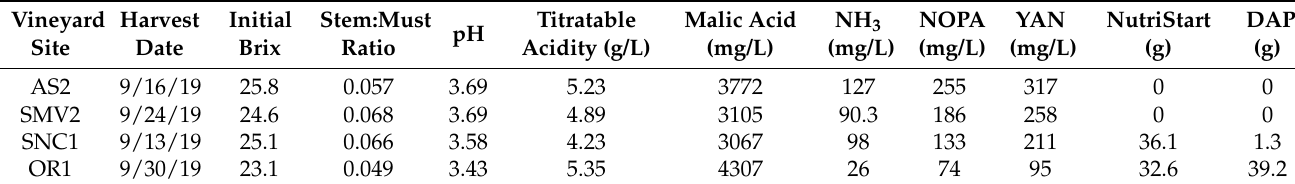
Table 2. Initial must chemistry and composition. Data in this table include: harvest dates, Stem:Must ratio, pH, titratable acidity, malic acid, free ammonia, Primary Amino Nitrogen (NOPA), Yeast Available Nitrogen (YAN), as well as the amount of NutriStart, and Diammonium Phosphate (DAP) nutrients added to SNC1 and OR1. Vineyard